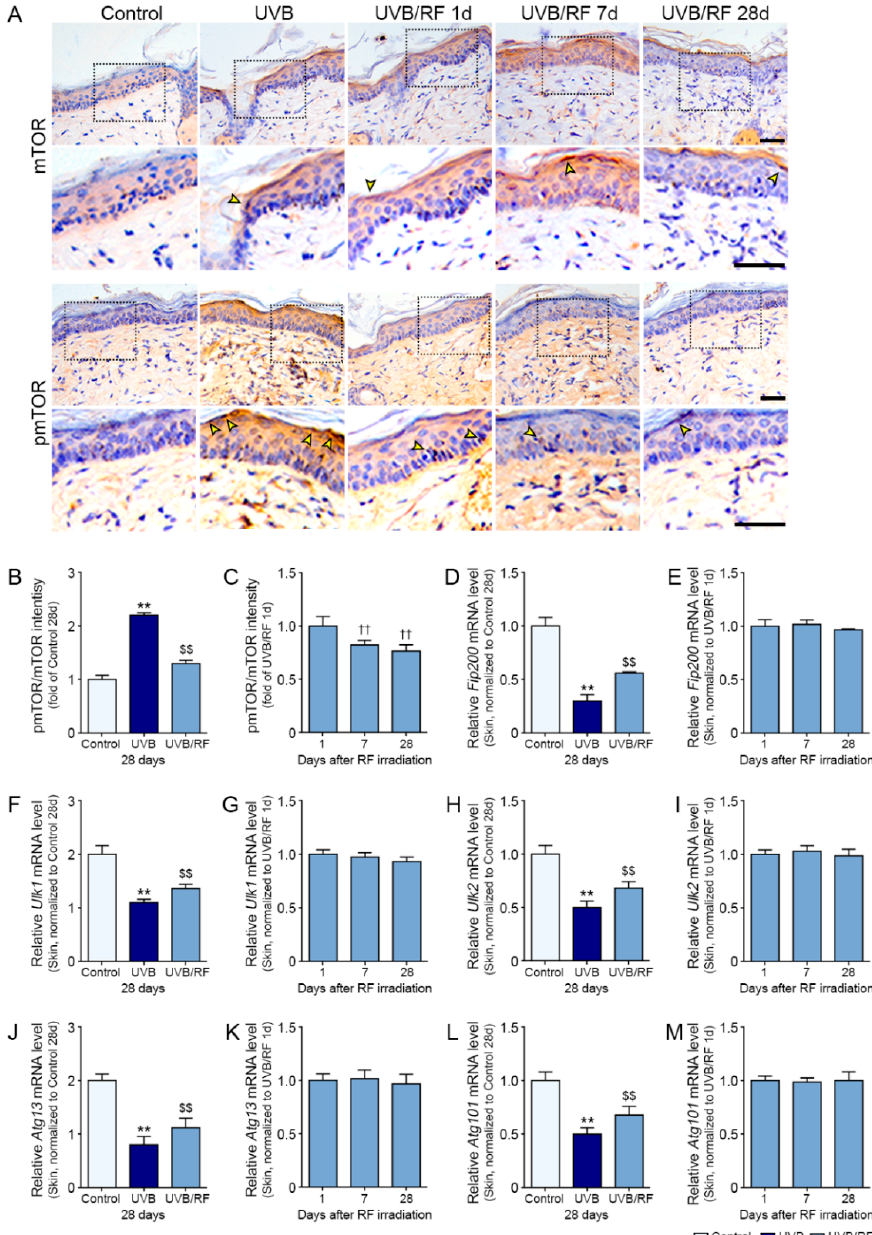
Figure 2. Activation effects of autophagy initiation response by RF irradiation in the UV-B-exposed animal model. ( A ) mTOR and pmTOR expression (arrows) in the epidermis of the UV-B-exposed mouse skins were assessed immunohistochemically (scale bar = 100 µm); ( B , C ) Quantitative ratios of representative mTOR and pmTOR images. Mouse skins were either with UV-B or with UV-B/RF in vivo, or otherwise not irradiated (control 28 days); ( D – M ) The mRNA expression levels of ( D , E ) FIP200, ( F , G ) ULK1, ( H , I ) ULK2, ( J , K ) ATG13, and ( L , M ) ATG101 were determined in autophagy initiation response-related factors in skin tissue. All mRNA levels were measured by qRT-PCR, normalized versus ACTB, and expressed relative to levels in the control 28 days group or 1 day after RF irradiation. Data are presented as mean ± SD. **, p < 0.01, vs. control 28 days; $$, p < 0.01, vs. UV-B 28 days; ††, p < 0.01, vs. 1 day after RF irradiation (Mann–Whitney U test). ATG, autophagy-related protein; mTOR, mechanistic target of rapamycin complex; pmTOR, phosphorylated mTOR; RF, radiofrequency; ULK, unc-51-like autophagy activating kinase 1; UV-B, ultraviolet-B; UV-B/RF, UV-B plus RF.